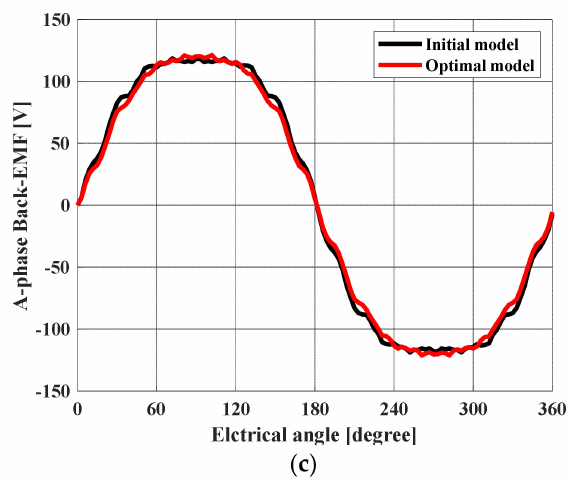
Figure 7. Characteristic comparison of initial model and optimal model. ( a ) Torque waveform; ( b ) Cogging torque waveform; ( c ) A-phase B-EMF waveform.